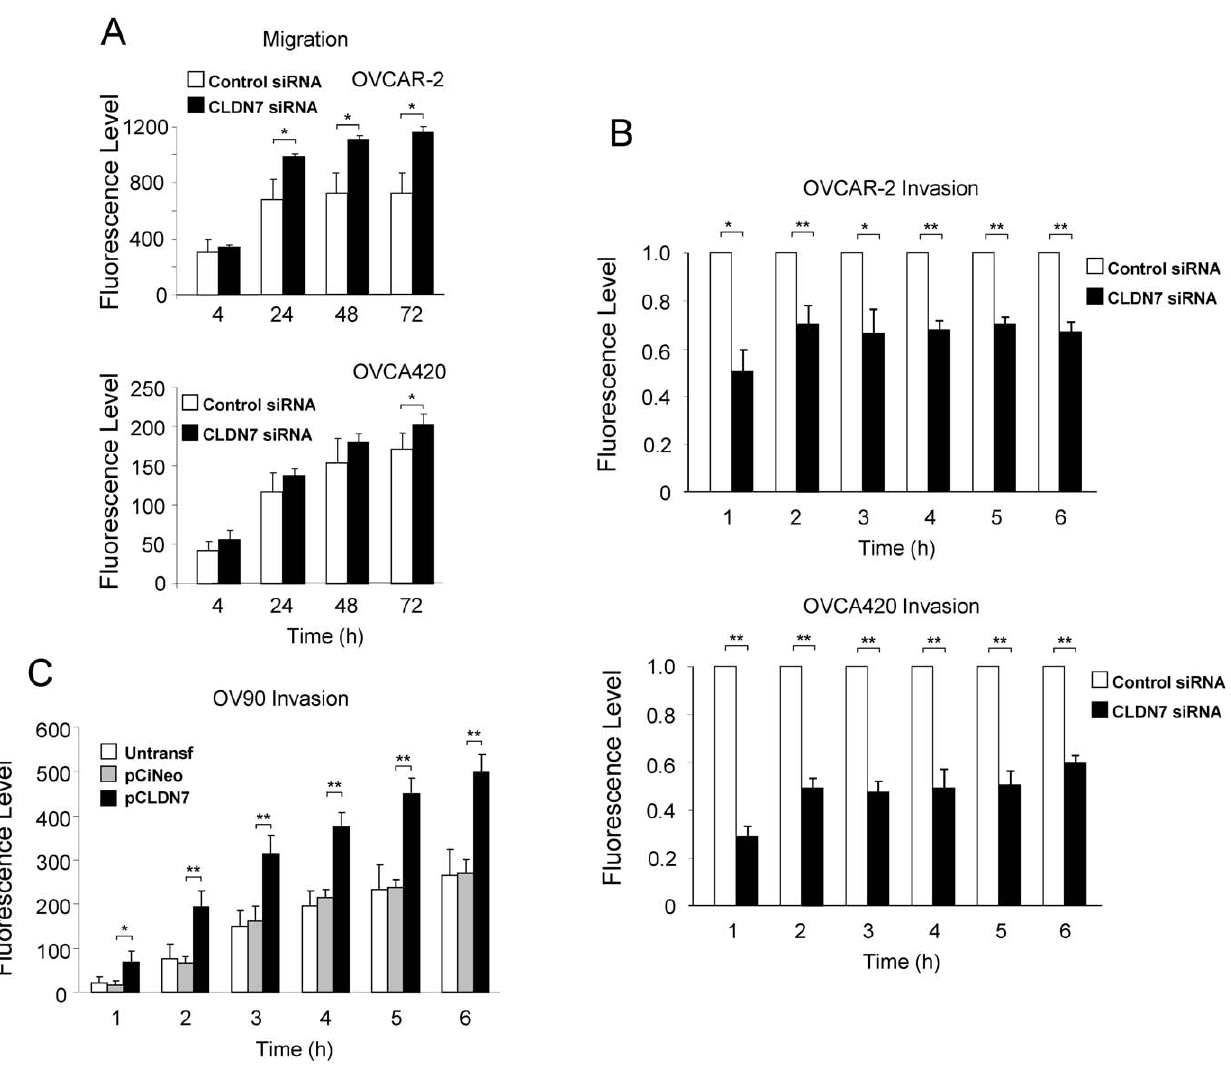
Figure 7. Effects of CLDN7 on the migration and invasion of ovarian cancer cells. A. Migration assays in OVCAR-2 and OVCA420 cells. The migration of cells with CLDN7 knocked down (dark bars) or control cells (white bars) was measured at different time point after the beginning of the assay. B. Boyden chamber invasion assay of OVCAR-2 and OVCA420 cells with and without CLDN7 knockdown. The number of invading cells was measured every hour for 6 hours. C. Invasion assays in a model of CLDN7 overexpression. Two stable lines, OV90-CLDN7 and OV90-CiNeo, as well as untransfected parental OV90 cells were used to test changes in invasion following CLDN7 overexpression. For all the results shown in this figure, the experiments were performed in triplicate and the results are shown as mean + / 2 S.E.M. An asterisk (*) indicated a p-value , 0.05, and a double asterisk (**), a p-value , 0.01.